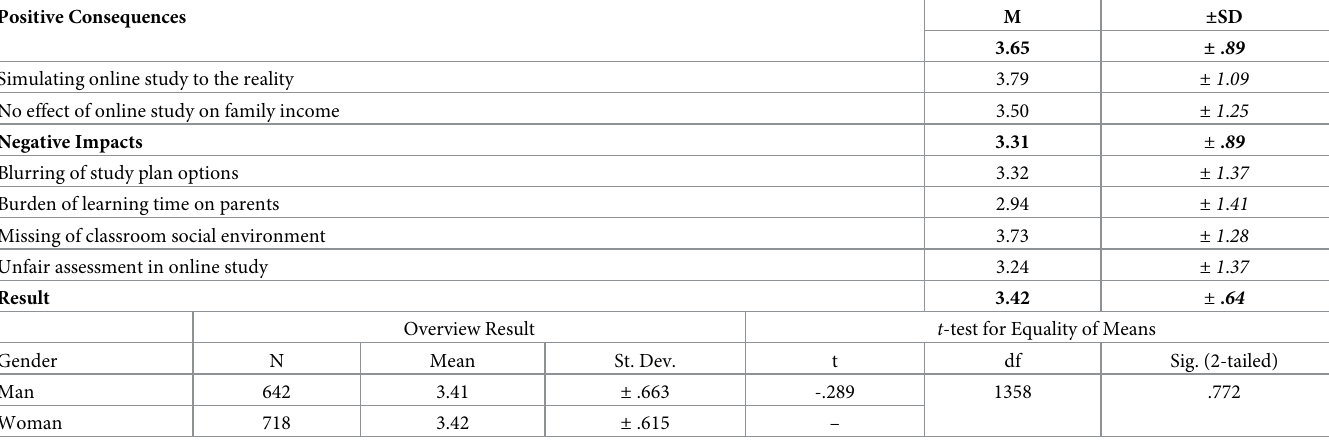
Table 7. Descriptive statistics for the impacts of COVID-19 on online study aspect of students’ lives.